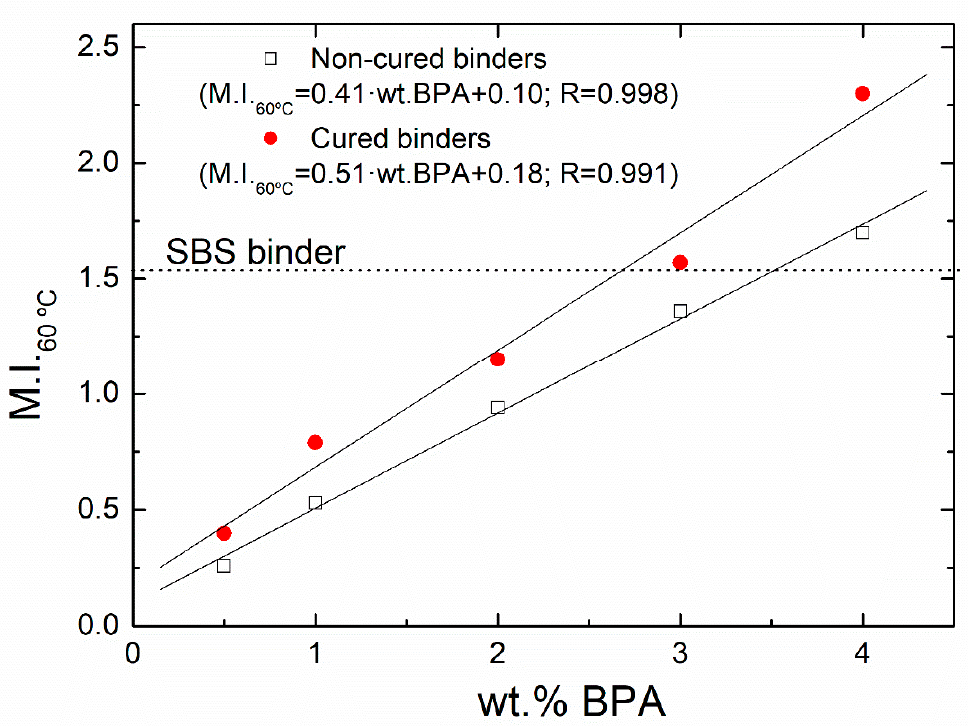
Figure 3. Evolution with epoxy concentration of the Modification Index (M.I. 60 °C ) achieved at 60 °C for noncured and cured binders.